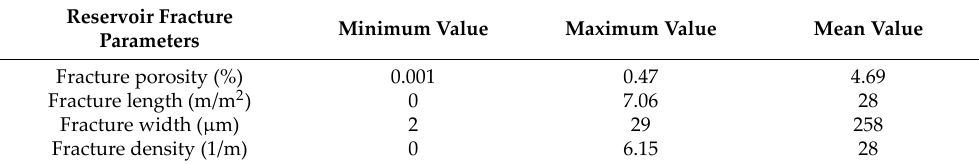
Table 1. Resistivity imaging logging fracture parameter